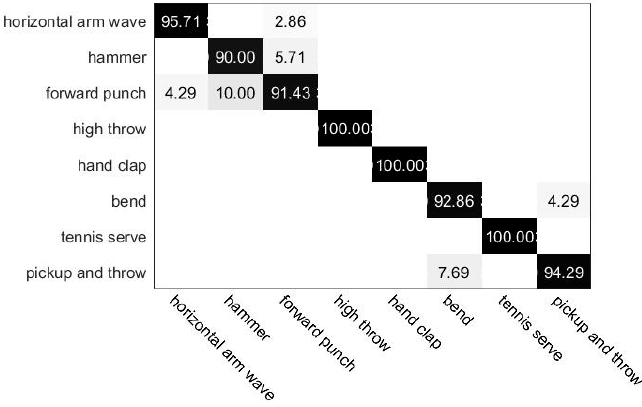
Figure 3. Confusion matrix of our proposed method in AS1.